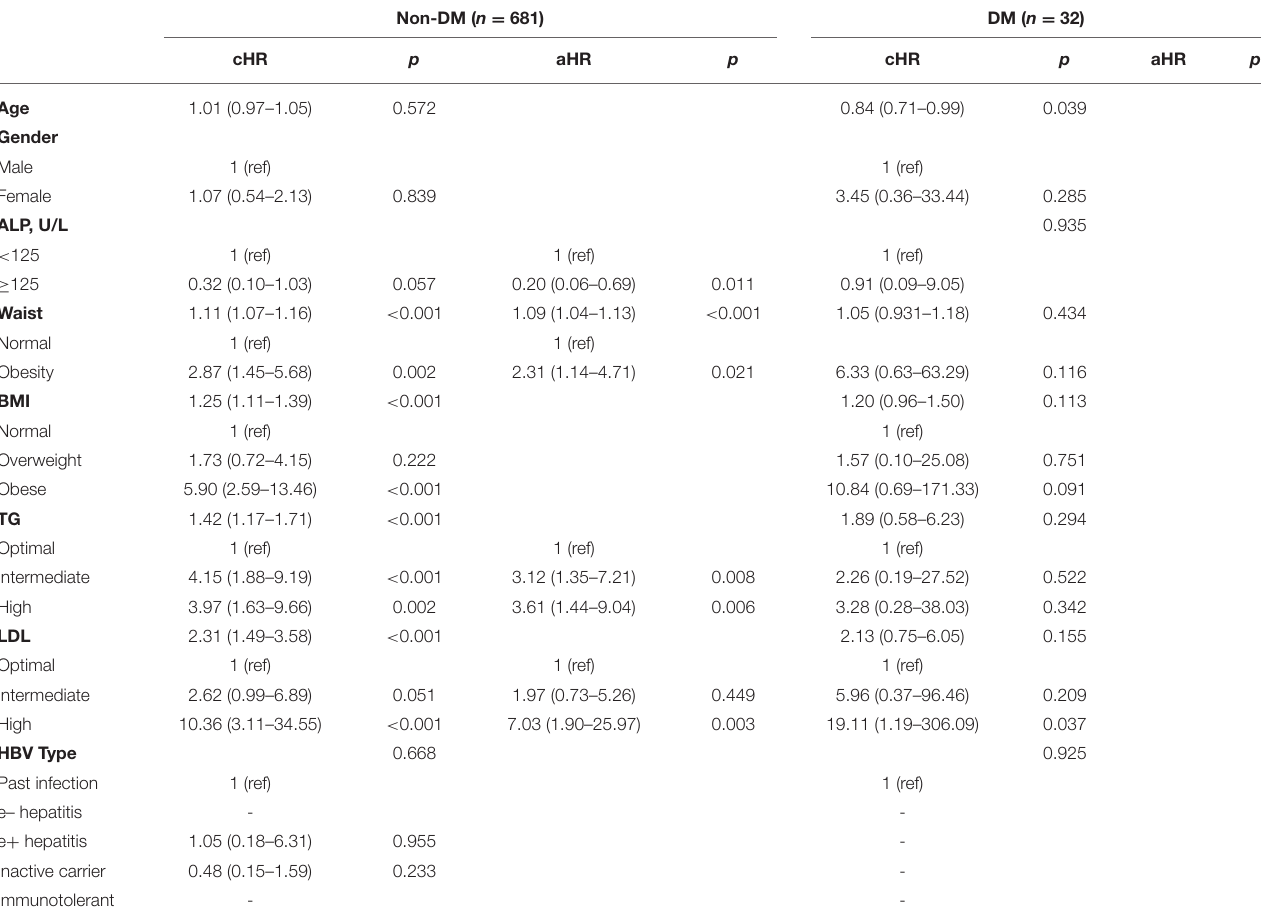
TABLE 4 | Effects of risk factors for NAFLD incidence in diabetic and non-diabetic